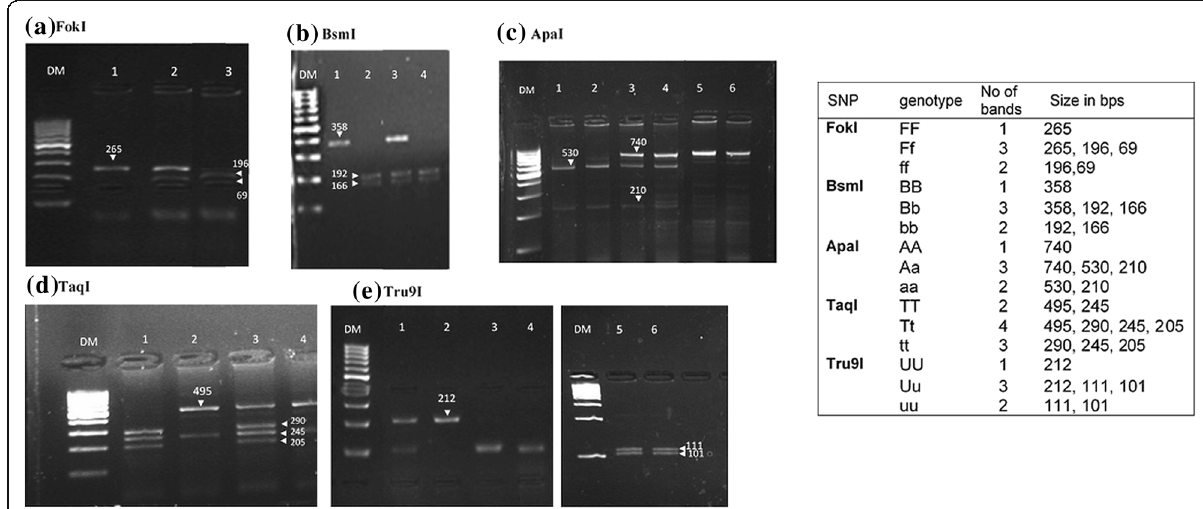
Fig. 1 PCR-RFLP based genotyping of VDR gene polymorphisms. VDR SNP was genotyped by PCR-RFLP (described in methodology), and the RFLP bands were visualized by 3% agarose gel electrophoresis. a FokI: lane 1: FF, lane 2: Ff, and lane 3: ff. b BsmI: lane 1: BB, lane 2, 4: bb,